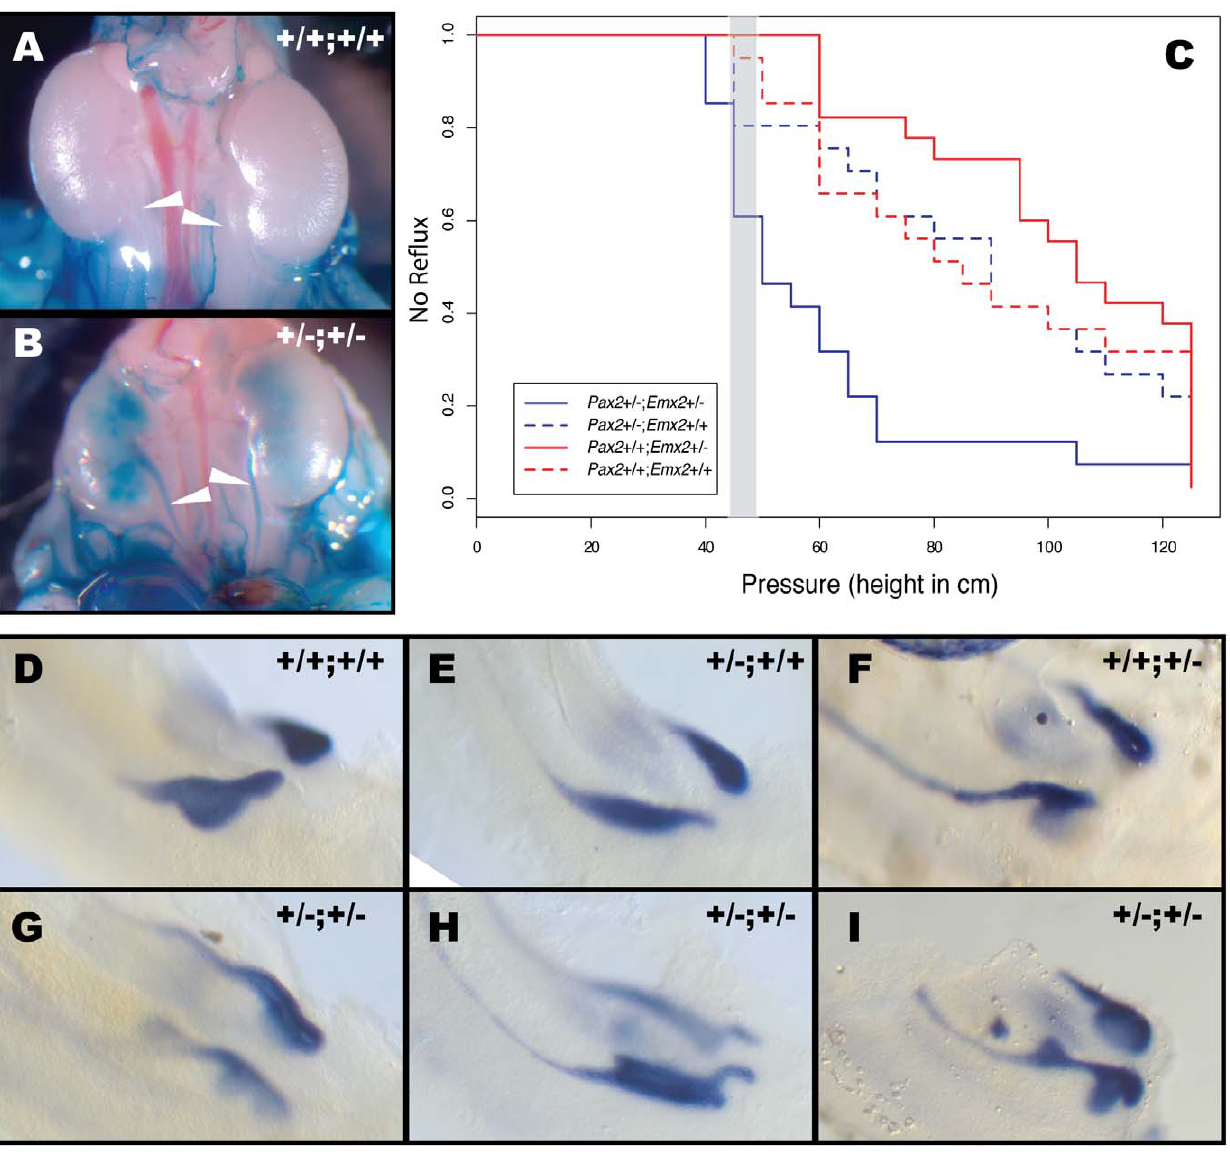
Figure 3. Highly penetrant VUR associated with ureter budding defects in Pax2 + / 2 ;Emx2 + / 2 embryos. (A,B) Intravesical dye injection in wild-type (A) and Pax2 + / 2 ;Emx2 + / 2 embryos (B) at P0. C) Graph of non-refluxing animals relative to pressure (reflected by height of dye reservoir from bladder level) for wild-type (n=20), Pax2 + / 2 (n=20), Emx2 + / 2 (n=22) and Pax2 + / 2 ;Emx2 + / 2 (n=20). Grey area represents the average height/pressure at which the urethra voids + / 2 0.5 SD. (D–I) Whole-mount in situ hybridization for Ret at E11.0 in wild-type (D), Pax2 + / 2 (E), Emx2 + / 2 (F) and Pax2 + / 2 ;Emx2 + / 2 embryos (G–I). Note the ureteric bud malformations in compound heterozygous animals, including double buds in the same or opposite orientations, ureteric bud enlargement and ectopic